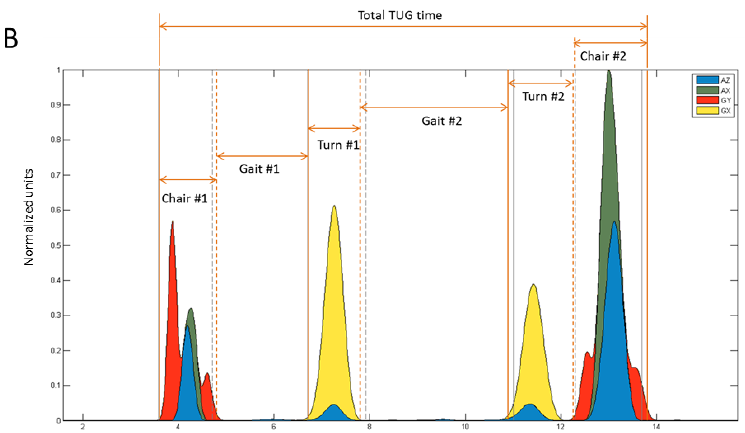
Figure 3. Timed up and go event time determination from the inertial measurement unit’s (IMU) accelerometer and gyroscope channel data. ( A ) When mounted on the torso the IMU’s X axis in the superior/inferior direction, the Y axis is in the medio/lateral direction, and the Z axis is in the anterior/posterior direction. The gyroscope X channel therefore registered the turning motion, and the gyroscope Y and accelerometer Z and X channels registered the chair activity. ( B ) The raw signals were filtered with a zero-lag 4th order Butterworth filter at 10 Hz, rectified, power-scaled, and normalized from 0–1, producing the sensor impulse profile shown in the lower portion of the figure. A fixed threshold value is then used to find the on-off times of each impulse, thus defining the sub-task transition events.